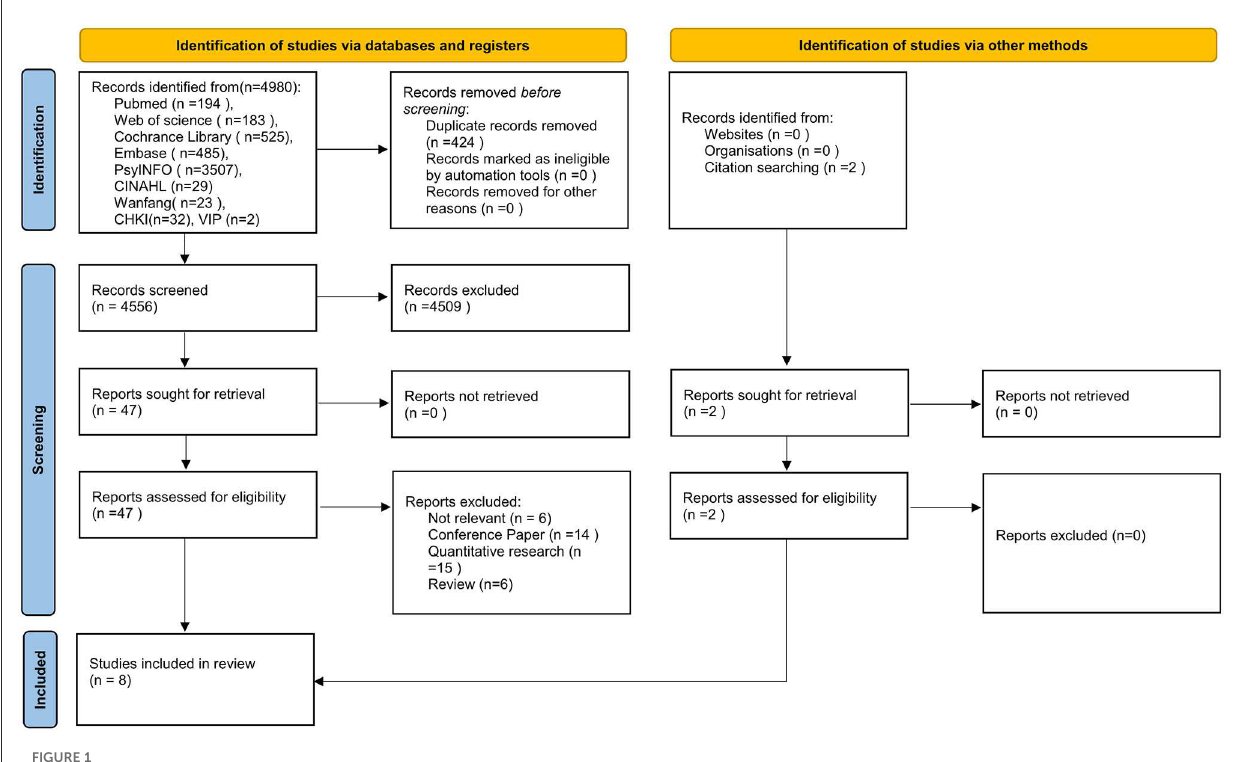
FIGURE1 Flowchart of the